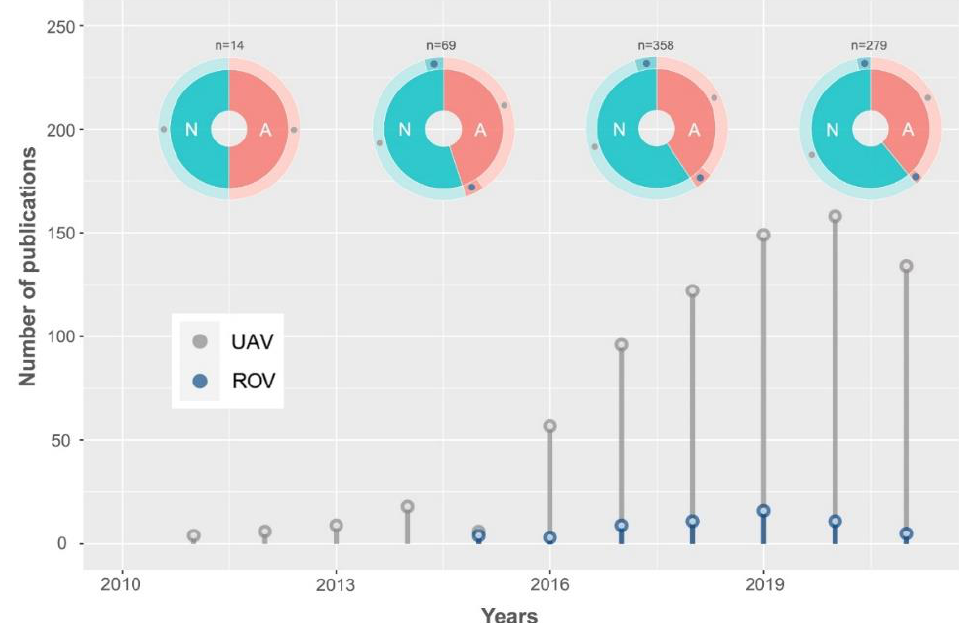
Figure 7. Lolly plot presenting the use of unmanned aerial vehicles (UAVs) and remotely operated vehicles (ROVs) in the past 21 years. The ring plots on the upper part of the figure show the percentage of studies covering natural (N, in bluish) or artificial scenarios (A, in red) for each three-year period. n = number of total